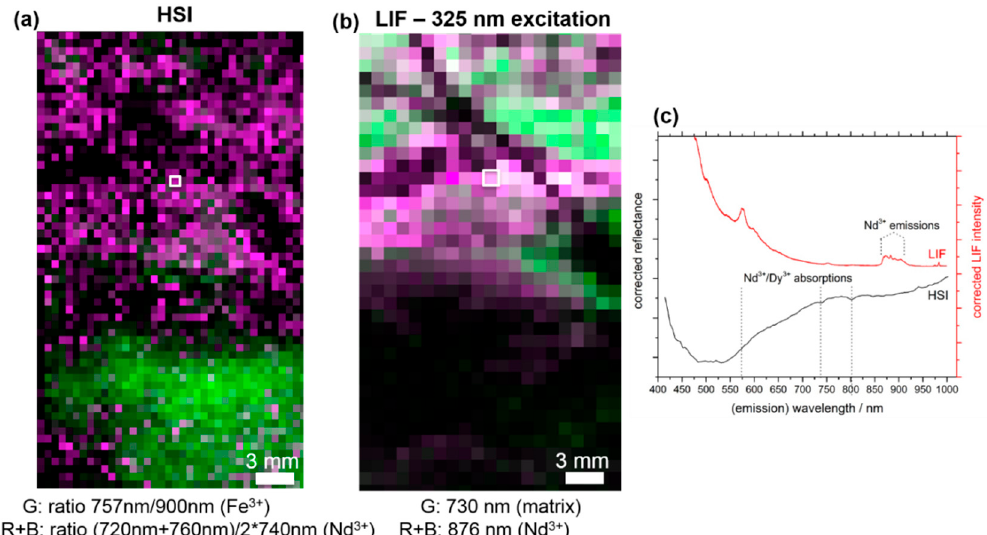
Figure 6. Comparison of false-color maps from the Lofdal sample. ( a ) Hyperspectral imaging (HSI) map ( b ) LIF map under 442 nm excitation. For the HS image visualization, band ratios of Fe 3 + -related (green) and Nd 3 + -related (magenta) absorption features are used. The ratios are calculated by the division of the intensities from the absorption band and from a band that is not a ff ected by this absorption signal. Magenta coloring in the LIF map corresponds to higher relative occurrences of Nd 3 + ions, while green areas are correlated to the luminescence from the calcitic host rock. ( c ) The comparison of LIF and HSI spectra from one pixel (white squares in ( a , b )) with REE occurrence reveals the di ff ering sensitivity of each method. Dashed lines mark the position of potential REE-related absorption features in the HSI spectrum based on previous studies